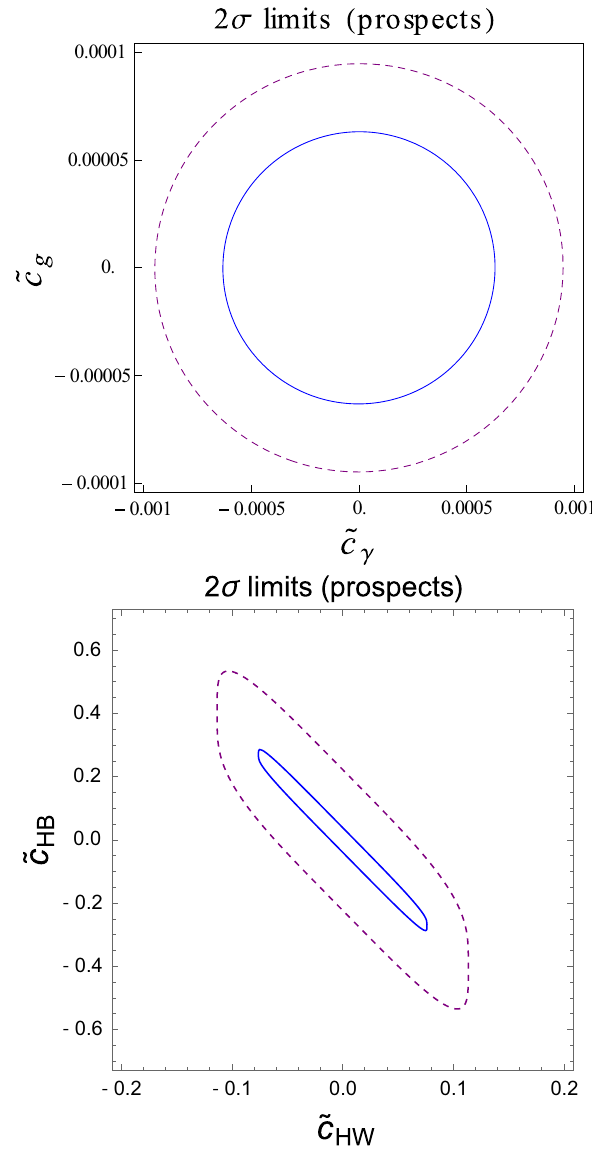
Fig. 3 LHC sensitivity to the ˜ c γ and ˜ c g (left) and on the ˜ c HW and ˜ c HB parameters (right). We show the 95% confidence level reach for an integrated luminosity of 300 fb − 1 (dashed purple) and 3000 fb − 1 (solid blue), neglecting the effects of the theoretical